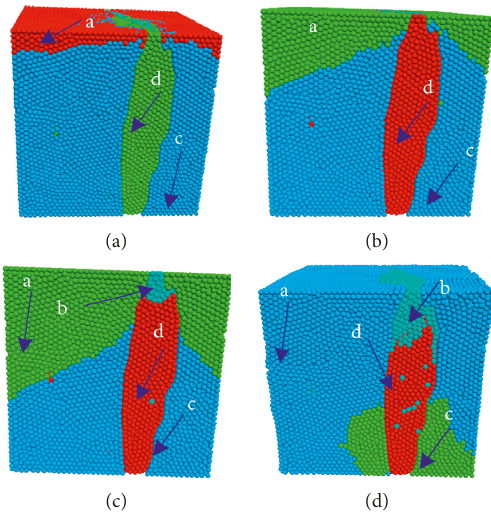
Figure 18: Damage initiation and evolution states under positive y - load at loading points A ∼ D (in this figure, a and b represent the failure zone of coal and gangue phases, respectively, c and d represent the undamaged zone of coal and gangue phases,